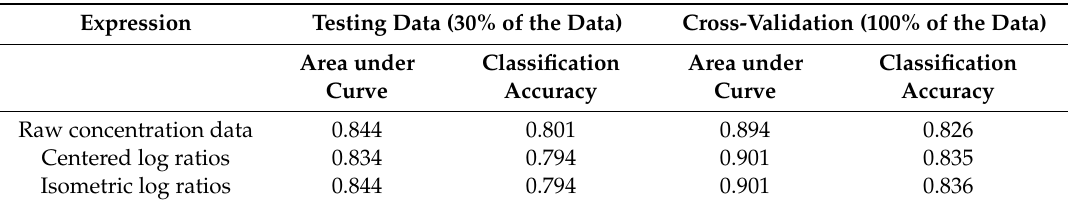
Table 5. Comparison between expressions for tissue nutrient compositions of peach trees using the random forest model.